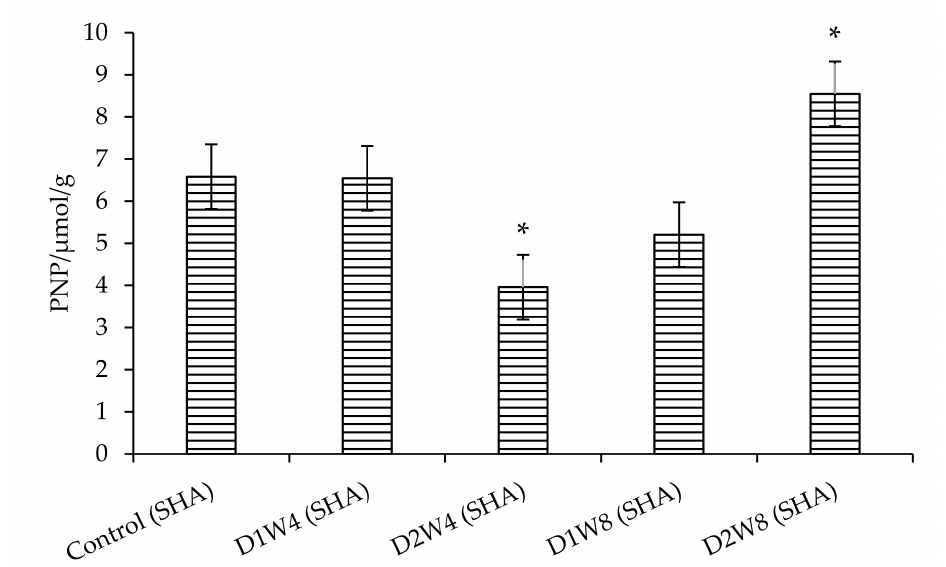
Figure 5. Glucosidase enzyme activity (GlA) of slightly humous Arenosol control (SHA): Control slightly humous Arenosol. D1W4 (SHA): Dose 1 week 4 (slightly humous Arenosol). D2W4 (SHA): Dose 2 week 4 (slightly humous Arenosol). D1W8 (SHA): Dose 1 week 8 (slightly humous Arenosol). D2W8 (SHA): Dose 2 week 8 (slightly humous Arenosol). * indicates significant difference at p < 0.05 (calculated by Duncan-test) between control and compost tea treated